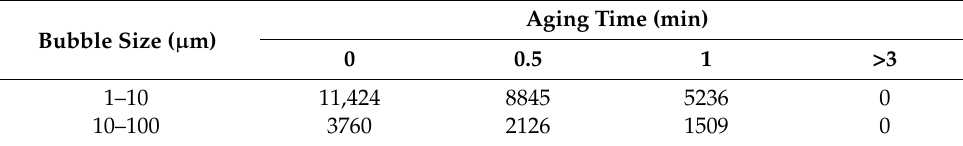
Figure 4. Variation of aqueous dispersion as a function of ageing time, at preparation time of 2 min, and aeration rate of 0.5 L/min (aging time ( a ): 0 min, ( b ): 0.5 min, ( c ): 1 min, and ( d ): >3 min). Table 1. Variation of number of micro-bubbles with ageing time (when the preparation time = 2 min, and aeration rate = 0.5